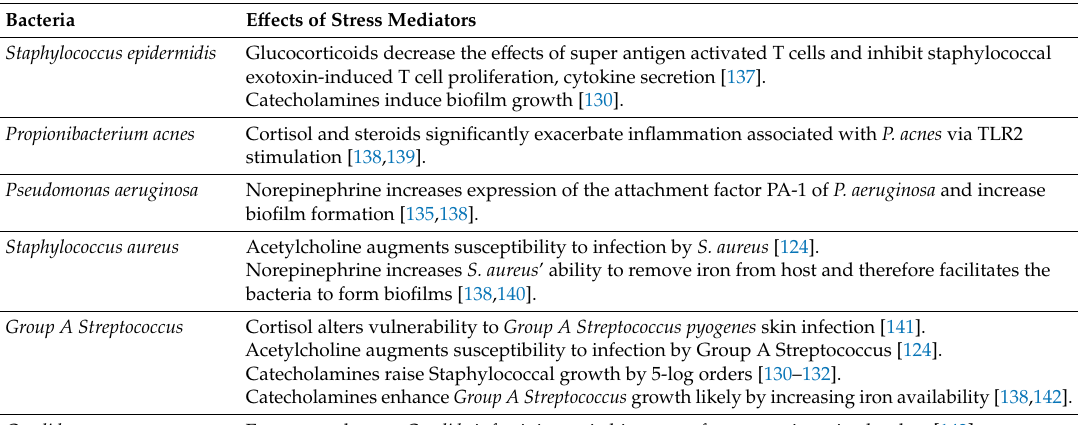
Table 2. E ff ects of stress mediators on the skin